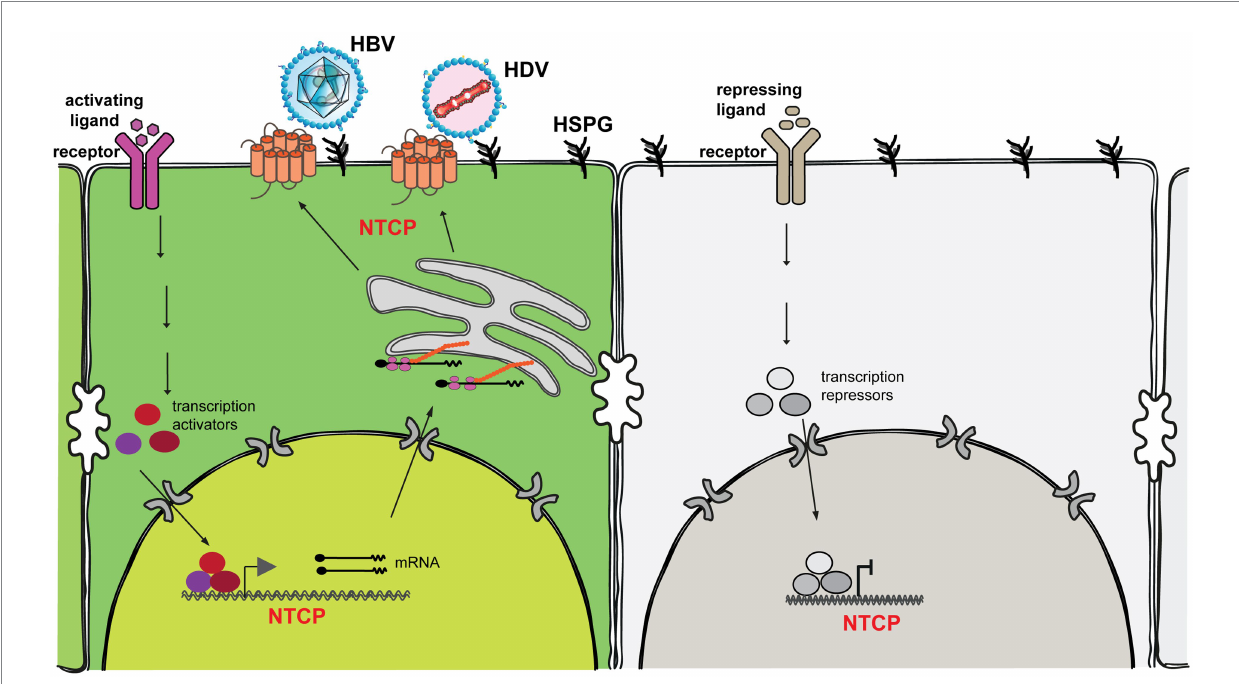
FIGURE 1 Sodium taurocholate cotransporting polypeptide (NTCP) is a hydrophobic transmembrane glycoprotein containing nine well-ordered transmembrane α -helices with N-terminus at the extracellular surface and C-terminus at the intracellular side (Asami et al., 2022; Liu et al., 2022; Park et al., 2022; Qi and Li, 2022). NTCP is distributed mainly on the basolateral membrane of hepatocytes and functions as an uptake transporter for bile salts. NTCP also essentially supports the entry of HBV and HDV into hepatocytes through the interaction with the preS1 region of the viral envelope protein. Its function is strictly regulated at both the transcriptional and posttranslational levels. Transcriptional Regulation: Substrate (e.g., bile acids), cytokines (e.g., TNF- α , IL-1 β , IL-6), liver injury (e.g., cholestasis), and hormones (e.g., prolactin, growth hormone, glucocorticoids, estrogen, thyroid hormone) all regulate transcription of the NTCP gene (Cheng et al., 2007; Bouezzedine et al., 2015; Yan et al., 2019). These ligands bind to their corresponding cellular receptor to kick off signaling transduction, leading to the activation and formation of multiple transcription activators/suppressors to activate/suppress NTCP gene expression. Posttranslational regulation: To become a functional bile salt transporter and an entry receptor for hepatitis B and D viruses, NTCP is destined to be localized to the hepatocyte plasma membrane. This localization is regulated by several posttranslational modification events (e.g., phosphorylation, glycosylation, S-nitrosylation and ubiquitination; Anwer et al., 2005; Kuhlkamp et al., 2005; Schonhoff et al., 2011; Sargiacomo et al., 2018; Zakrzewicz et al.,